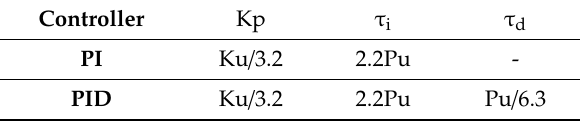
Table 3. Controller parameters for the Tyreus–Luyben method.